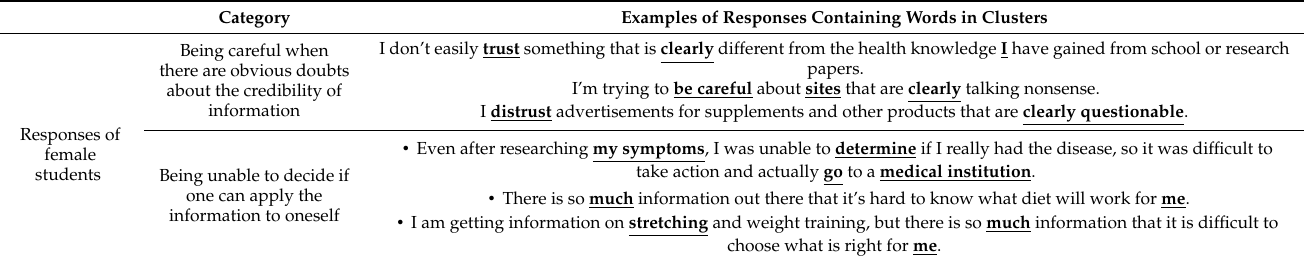
10 of 16 Figure 4. Co-occurrence network schema for visualizing the characteristic terms that frequently ap- peared in relation to gender in the contents of the open-ended responses. The more frequently the terms appeared together in the sentences, the thicker the arrow; the larger the circle, the more fre- quently the term appeared. Table 6. Content categorization of details in the open-ended responses. Category